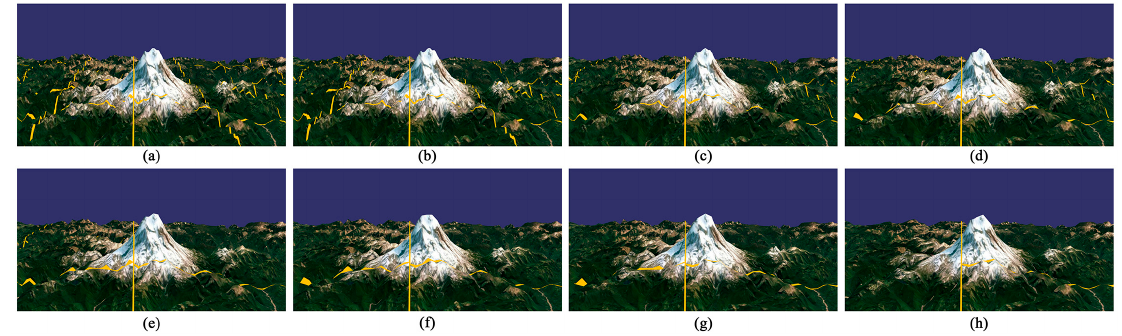
Figure 19. Comparison of visual effect under different screen-space error threshold using our method: The ρ thr ranges from 1.0 to 8.0 from ( a – h